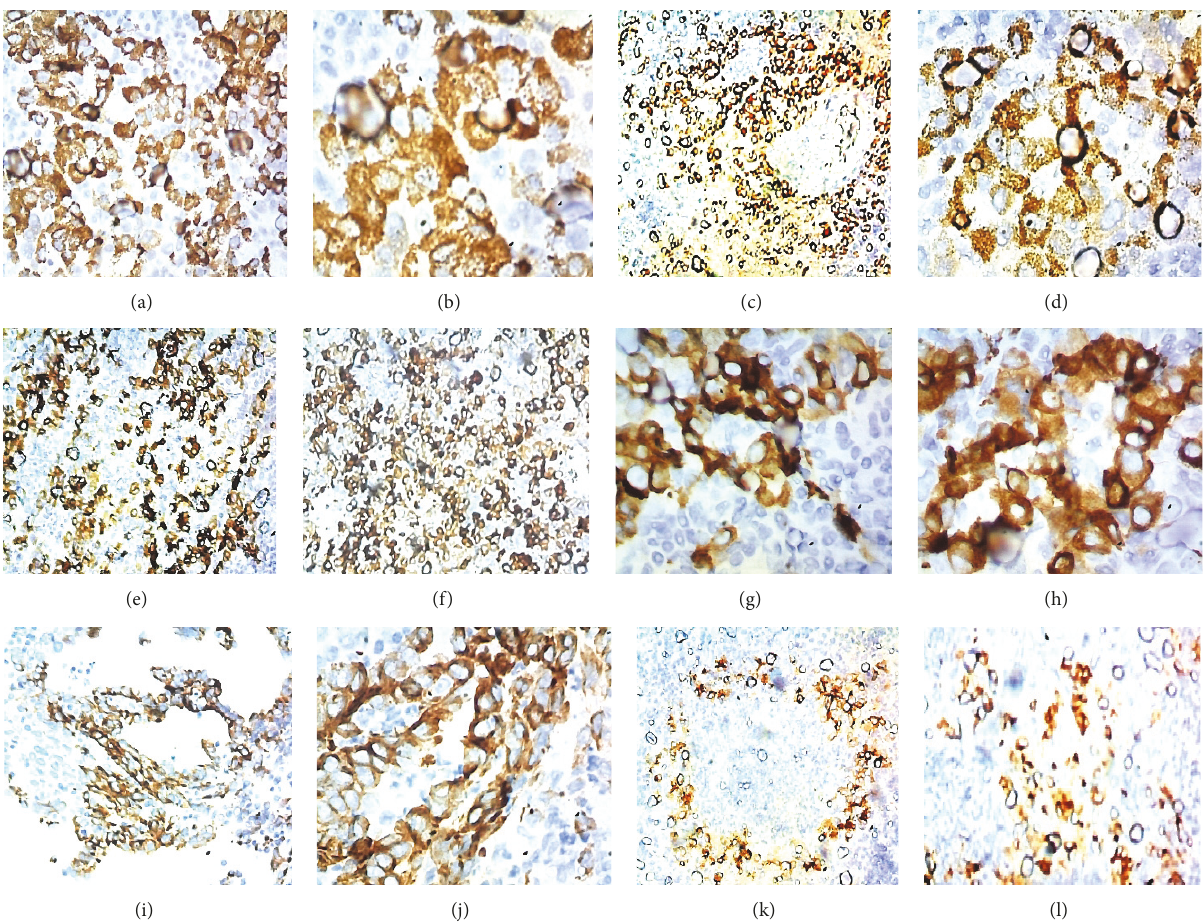
Figure 6: (a-b) Hepatocyte diffuse and intense positivity ( 100x,200x ); (c-d) TTF1, focal positivity ( 100x, 200x ); (e-f) CK7 focal positivity ( 100x ); (g-h) CK7 positivity in ductular structures ( 400x ); (i-j) CK19 positivity in canalicular structures ( 100x, 200x ); (k-l) 𝛼 FP focal positivity ( 100x